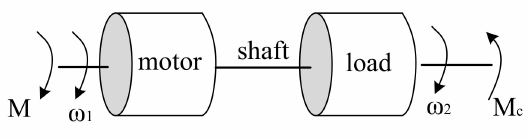
Figure 2. Two-mass system with a stiff